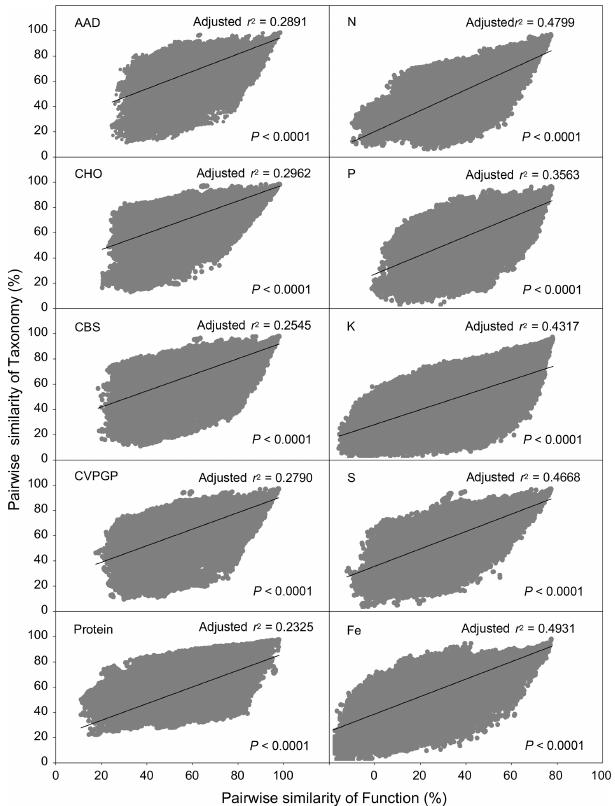
Figure 1. Relations between functional and taxonomic beta diversi- ties for broad and narrow functions. Pearson’s correlations between the pairwise Bray–Curtis similarity of microbial taxonomic compo- sition and the pairwise Bray–Curtis similarity of functional compo- sition for broad and narrow functions annotated using Subsystems at the function level (function) and RefSeq at the genus level (tax- onomy) are shown. For each correlation, r 2 and P values are given. Broad functions include AAD (amino acids and derivatives), CHO (carbohydrates), CBS (clustering-based subsystems), CVPGP (co- factors, vitamins, prosthetic groups, pigments), and Protein (protein metabolism). Narrow functions include N (nitrogen metabolism), P (phosphorus metabolism), K (potassium metabolism), S (sulfur metabolism), and Fe (iron acquisition and